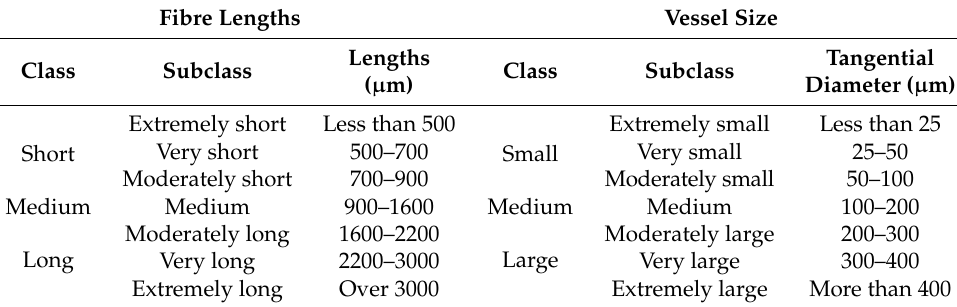
Table 2. Grouping of fibre lengths and vessel